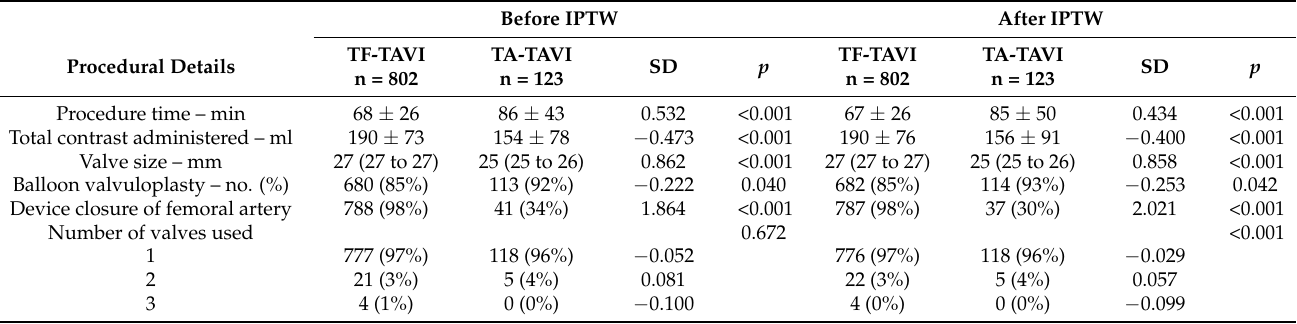
Table 2. Procedural details.